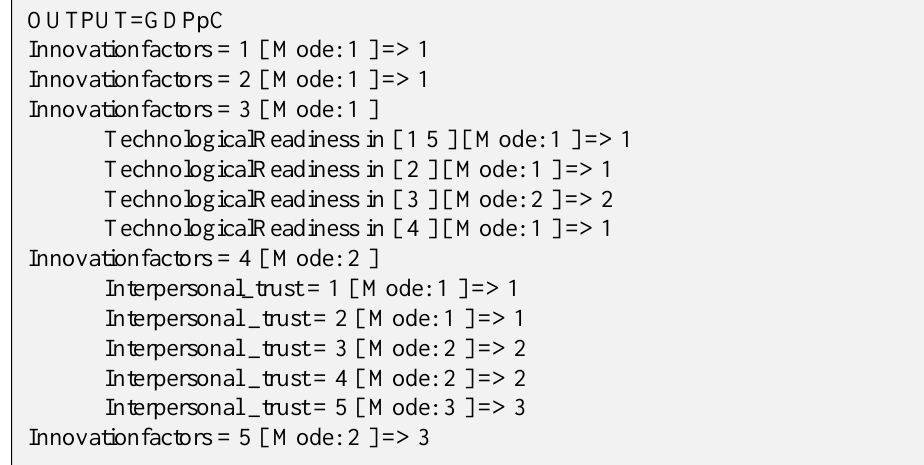
Figure 2 Decision tree model for GDPpC driving